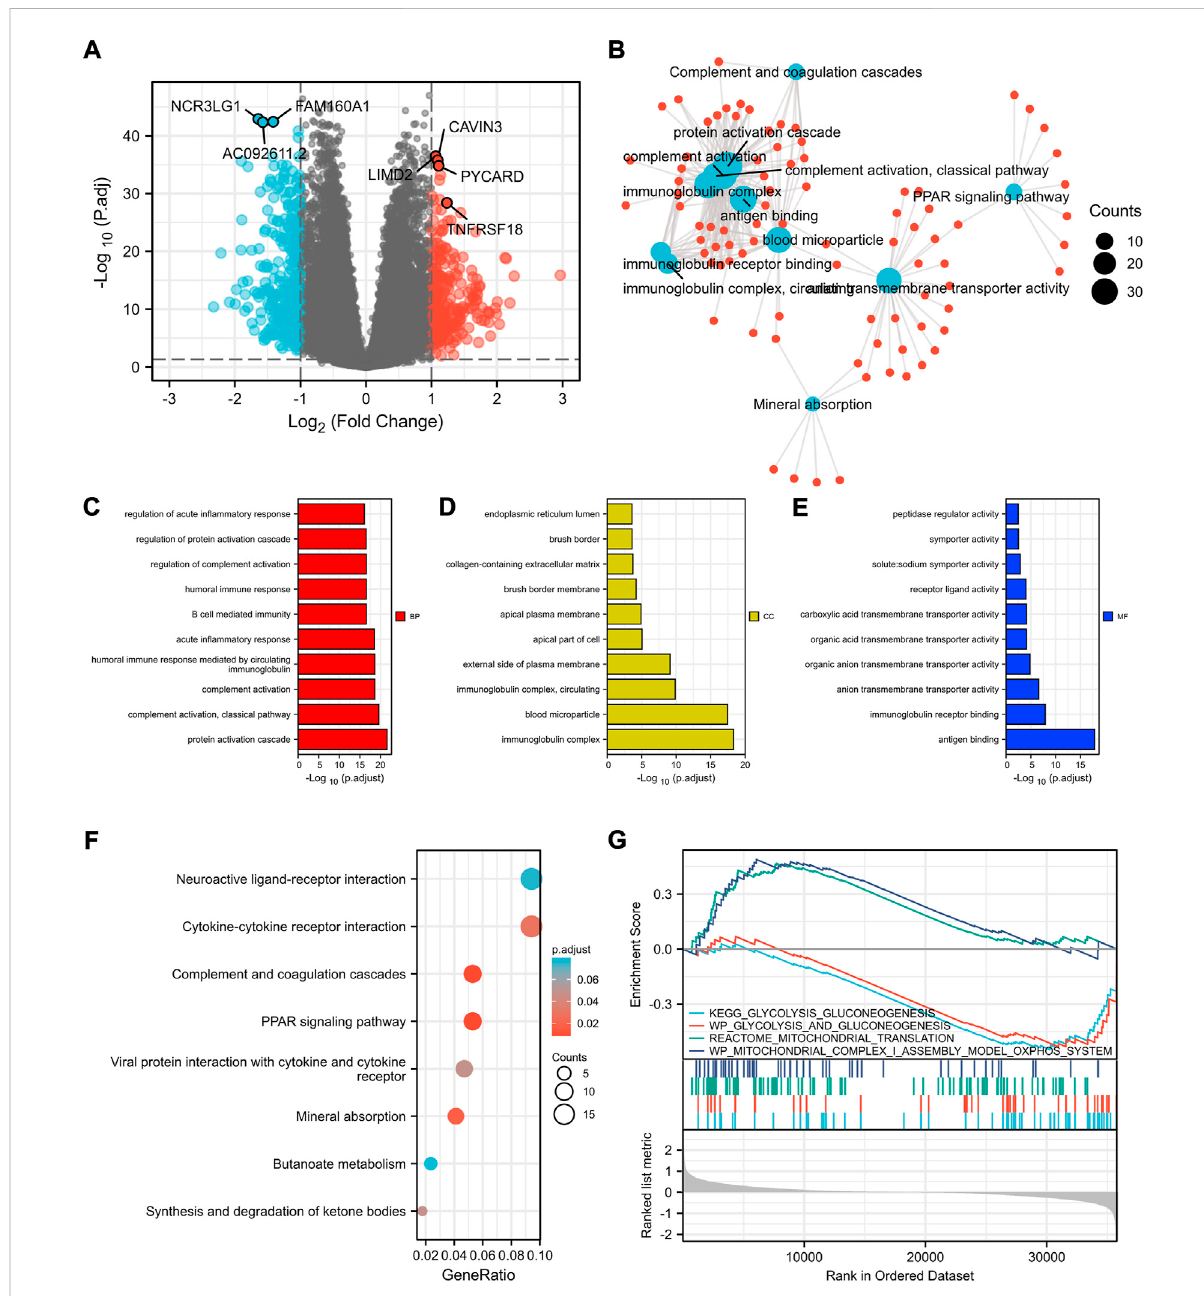
FIGURE 3 Identi fi cation of differentially expressed genes between the high- and low-risk patients according to cuprotosis-related signature and functional enrichment analysis. (A) Volcano plot of DEGs between high- and low-risk patients with ccRCC. Red and blue points represent up- and downregulated genes with statistical signi fi cance, respectively. (B) Network for comparing biological themes among gene clusters. GO analysis of DEGs between high- and low-risk patients includingbiologicalprocess (C) ,cellular components (D) ,molecularfunction (E) , andKEGG analysis (F) . (G) GSEA results of mitochondrial metabolism and glycolysis terms. DEGs, differentially expressed genes; GSEA, Gene Set Enrichment